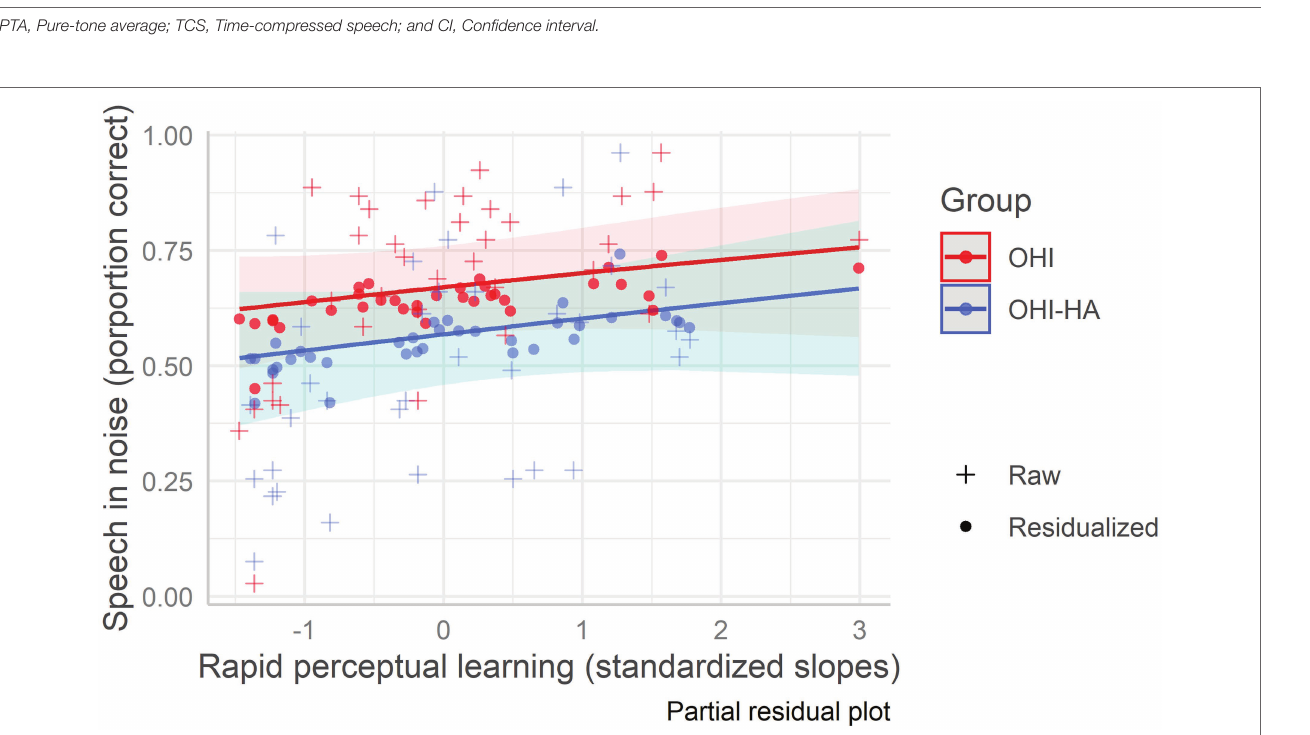
FIGURE 4 | Speech in noise recognition as a function of rapid learning among older hearing-impaired adults and older hearing-impaired adults who use hearing aids. Older hearing-impaired adults (OHI) in red; older hearing-impaired adults who use hearing aids (OHI-HA) in blue. The y -axis indicates the correct perception percentage of speech in noise, and the x -axis indicates the standardized rapid perceptual learning slope. The dots (residualized aggregate scores) mark the predicted scores; their deviation from the regression line indicates prediction error, while the pluses mark the raw/true scores. The shaded areas are the confidence